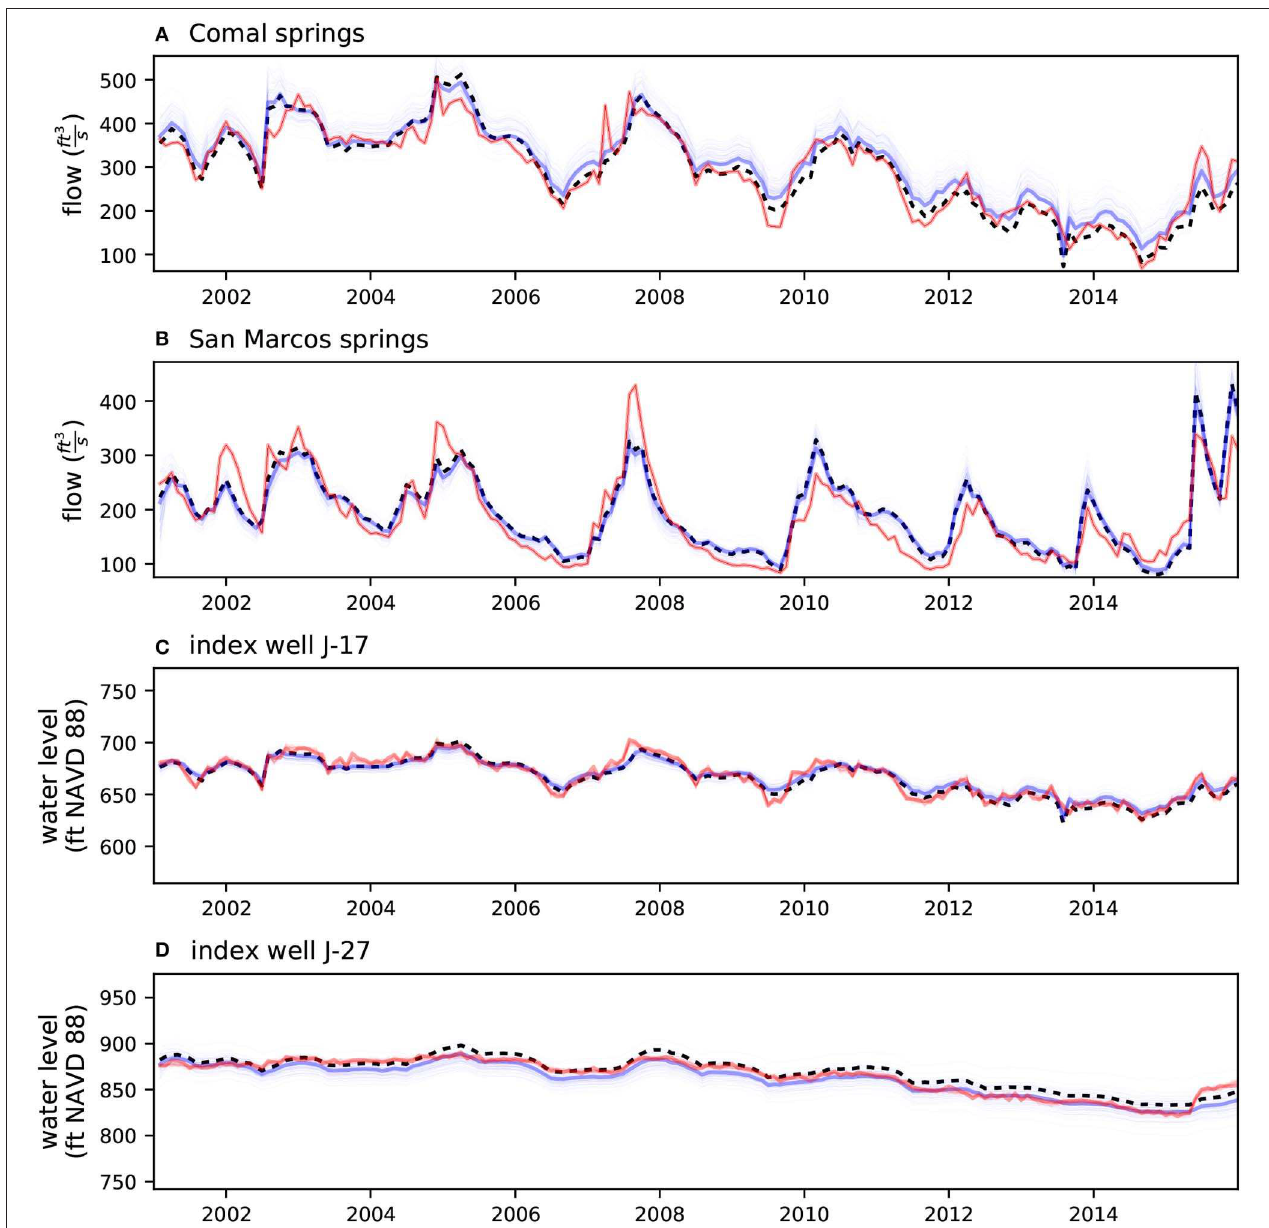
FIGURE 2 | Observed vs. simulated plots for the four locations of primary interest to groundwater resource managers for the history-matching simulation. Red trace is the observed series, dashed black trace is the simulation results from the existing model from Liu et al. (2017), thick blue trace is the maximum a posteriori simulation result (the posterior realization corresponding to the existing model inputs), light blue traces are the posterior ensemble simulation results. In general terms, the posterior ensemble closely reproduces the observed